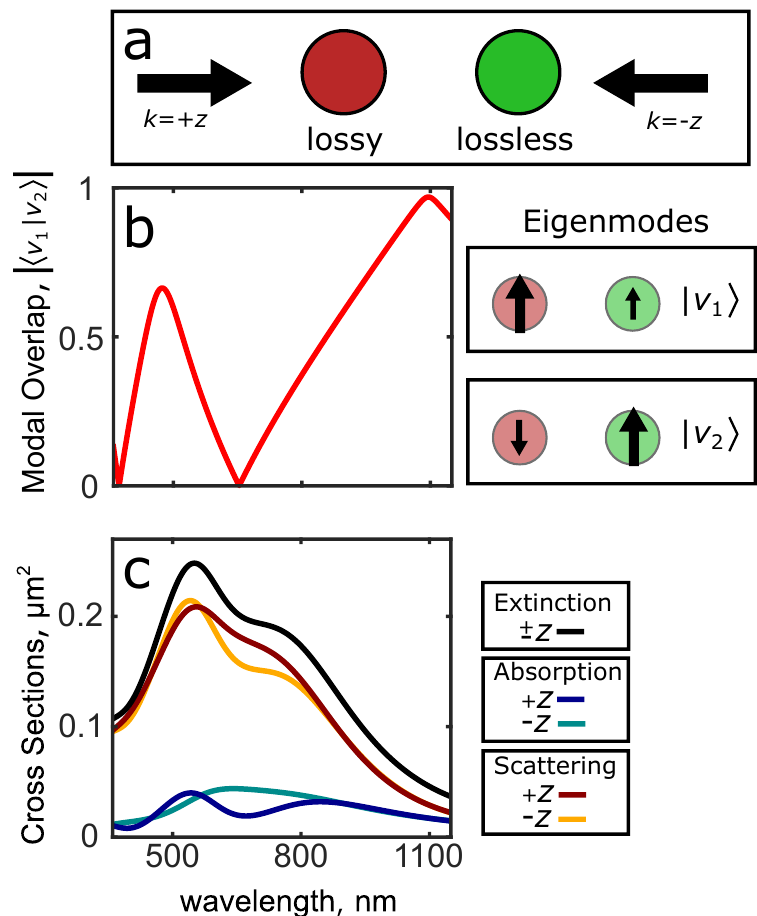
Figure 2. ( a ) Schematic of the system under consideration: a dimer consisting of lossy and lossless nanoparticles excited by plane waves propagating in opposite directions along the dimer’s principal axis. The parameters are in the text. We plot ( b ) the absolute value of the projection (Equation (17)) between the two normalized eigenmodes (Equation (16)) of this geometry. The simulated extinction, absorption and scattering cross-sections show the associated difference for oppositely-propagating plane